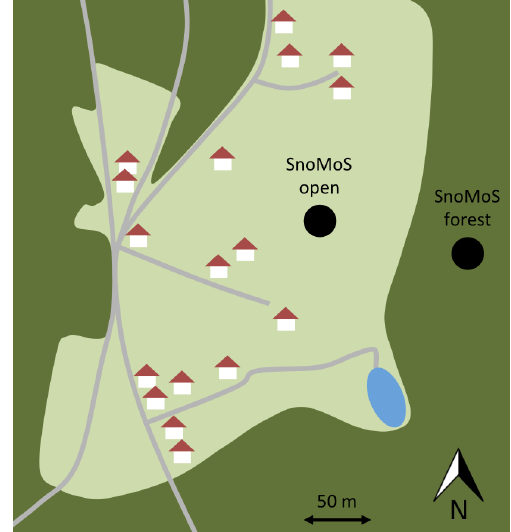
Figure 5. Schematic overview of the SnoMoS setup locations in- side and outside the forest canopy at site Vordersteinwald in the Black Forest mountain range (southwestern Germany, 800ma.s.l). The light green areas indicate grassland, the dark green areas forest, the grey lines streets and the light blue area a lake.